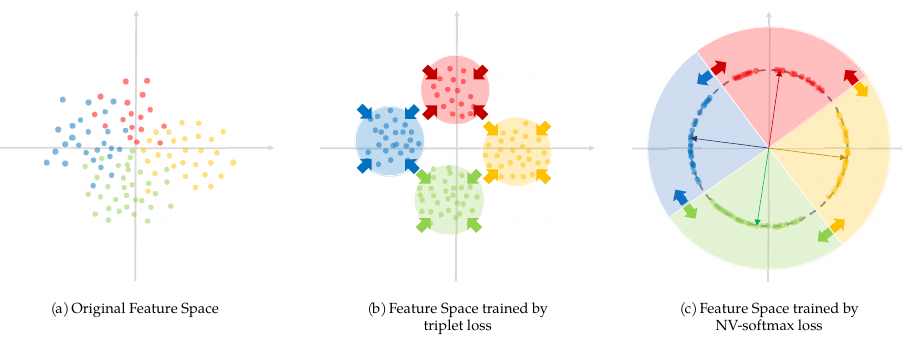
Figure 14. The feature space trained by different loss functions.